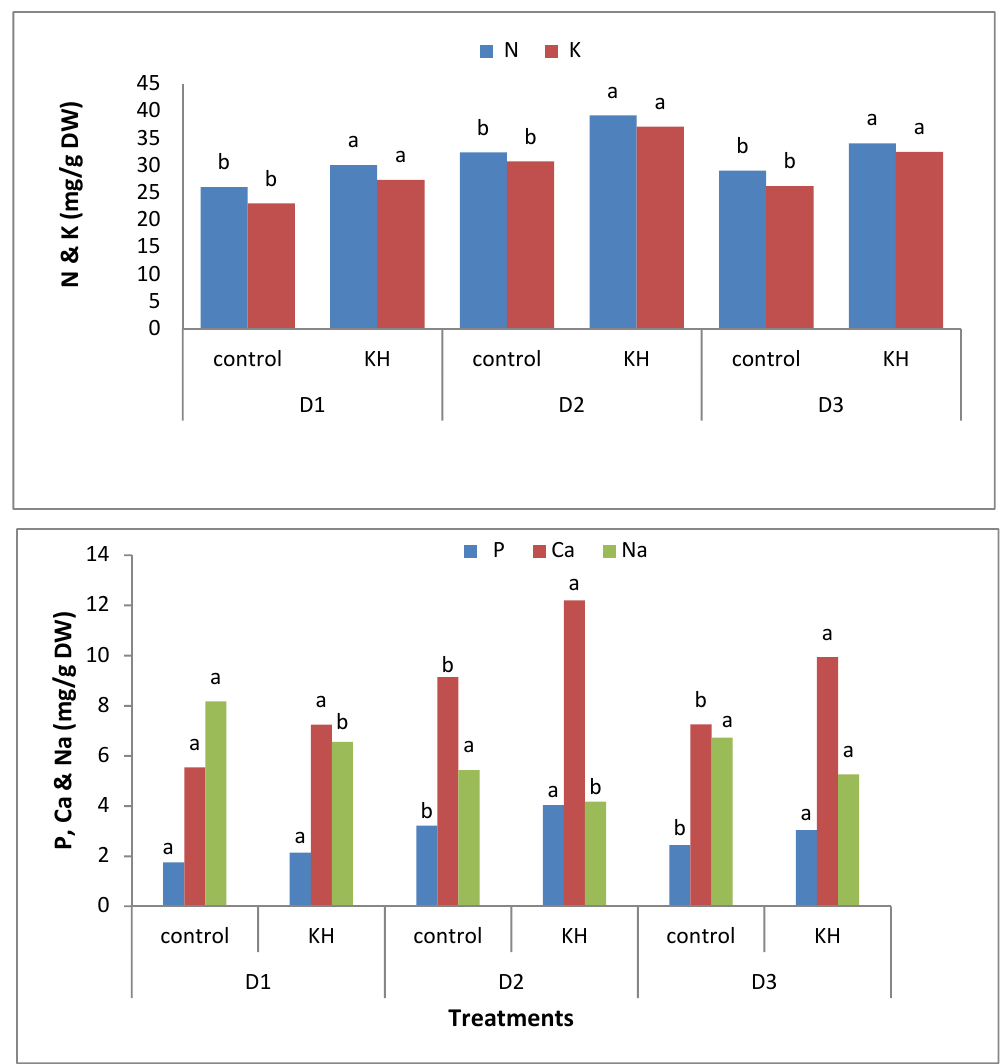
Figure 5. Effect of potassium humate (KH) application and planting density treatment on content of nitrogen (N), potassium (K), phosphorus (P), calcium (Ca) and sodium content (Na) (mg/g DW) of Vicia faba L. plants. For each parameter, treatments followed by the same letter are not significantly different at p ≤ 0.05.